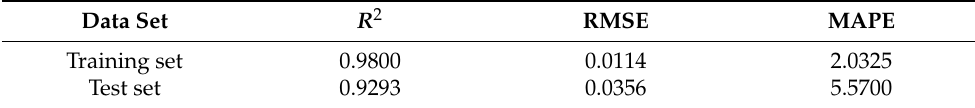
Figure 15. Prediction results of the training set based on Bayesian-LightGBM. Table 6. The comparison results of Bayesian-LightGBM on the training set and the test set. Data